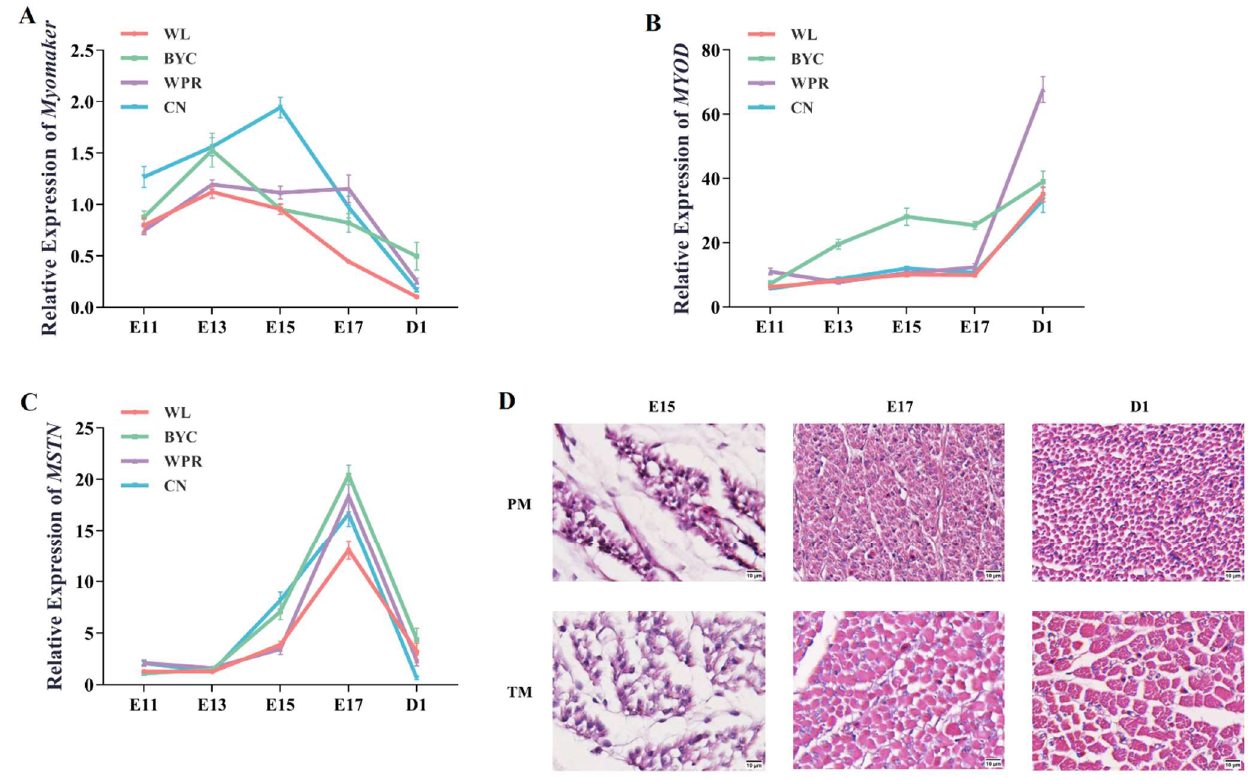
Figure 1. Time series of the three genes in the late embryonic stage. ( A ) Expression trends of the Myomaker gene in the pectoral and thigh muscles of White Leghorn chicken (WL), Beijing-You Chicken (BYC), White Plymouth Rock (WPR), and Cornish (CN) chickens. N = 24. ( B ) Expression trends of the MYOD gene in the pectoral and thigh muscle of WL, BYC, WPR, and CN chickens. N = 24. ( C ) Expression trends of the MSTN gene in the pectoral and thigh muscle of WL, BYC, WPR, and CN chickens. N = 24. ( D ) The two columns represent the pectoral muscle (PM) and thigh muscle (TM) of CN chickens. The myoblasts were still fusing at E15, and the contours of myofibers were not clear until E17, indicating that the formation of myofibers had been completed at E17. The diameter of myofibers of TM was obviously larger at D1. Scale bars: 10 µ m. For ( A – C ) the red, cyan, purple, and blue lines represent changes in the expression levels of the corresponding gene in muscles of WL, BYC, WPR and CN, respectively.